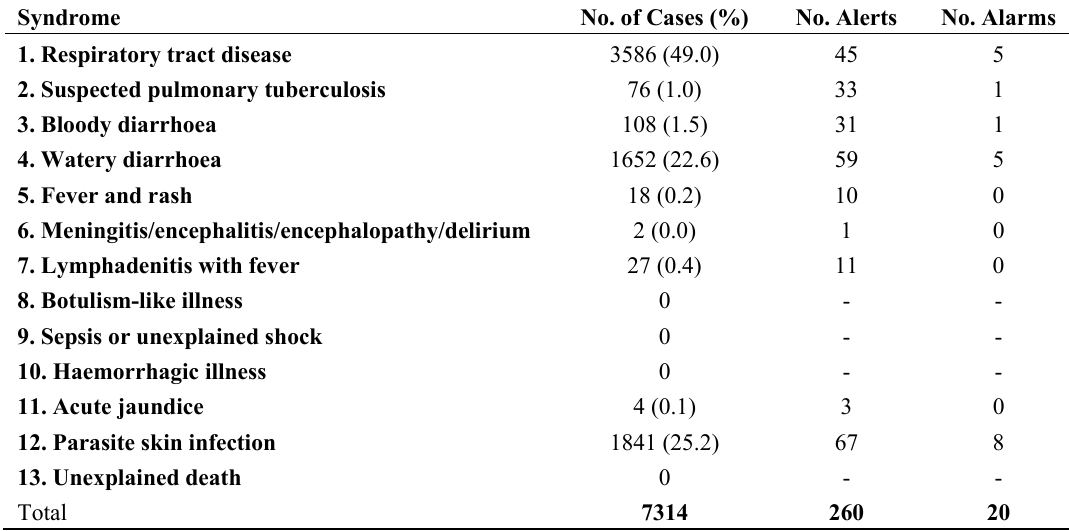
Table 2. Number of cases, alerts and alarms per syndrome, 1 May 2011–30 June 2013. Syndrome